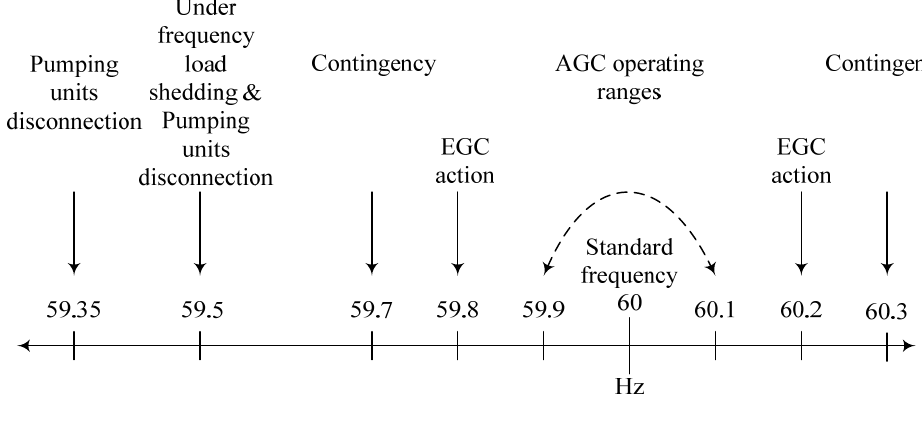
Figure 1. Schematic representation of the operational range of Taipower’s